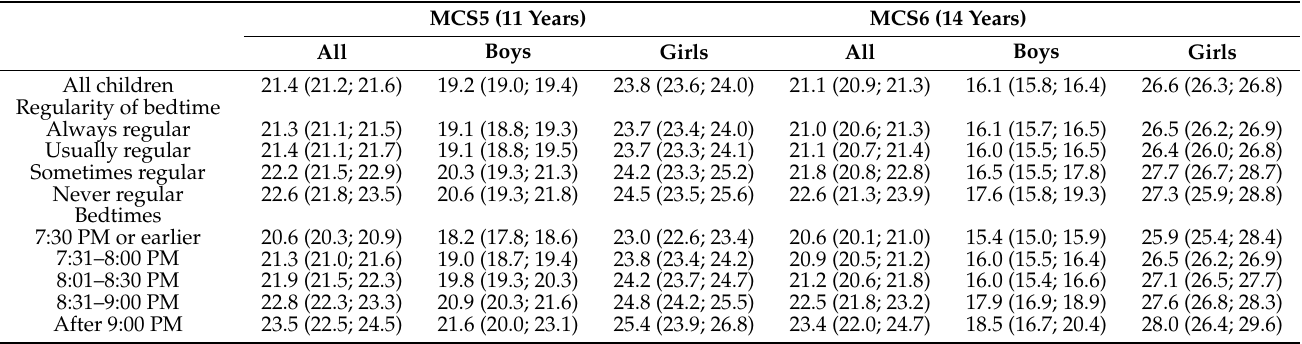
Table 1. Weighted mean body fat percentage (95% CI) at 11 and 14 years by term-time bedtimes and bedtime schedules of non-obese children at 7 years.